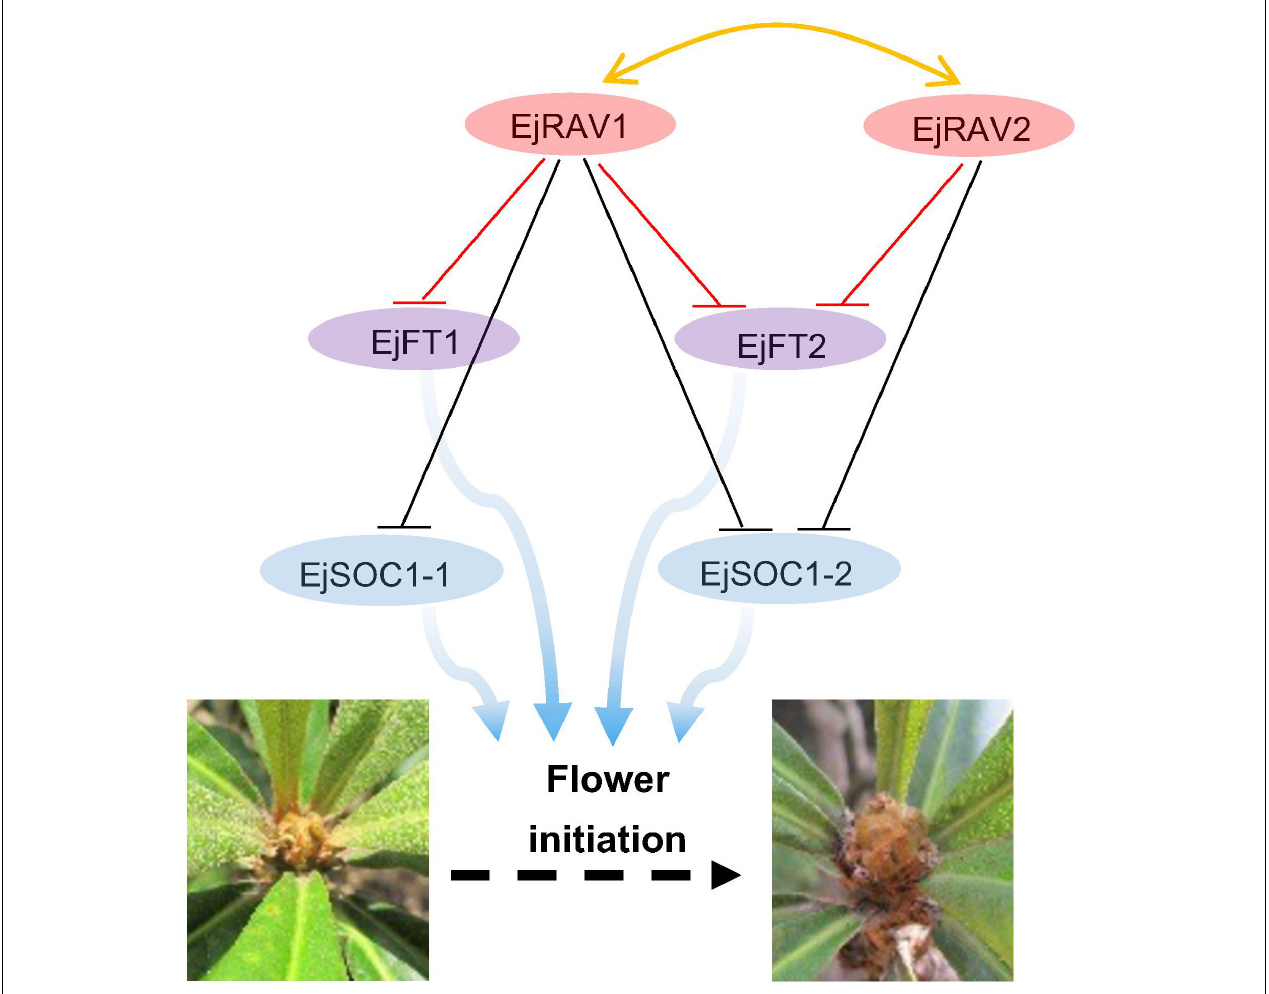
FIGURE 6 | A proposed model for EjRAV1/2 to regulate flowering time. The central network shows that EjRAV1/2 repress FT and SOC1 homologs expressions to delay flowering in an annual production season of loquat. The arrows represent promotion of FT and SOC1 homologs on flower initiation. The T arrows represent transcriptional repression of EjRAV1/2 on FT and SOC1